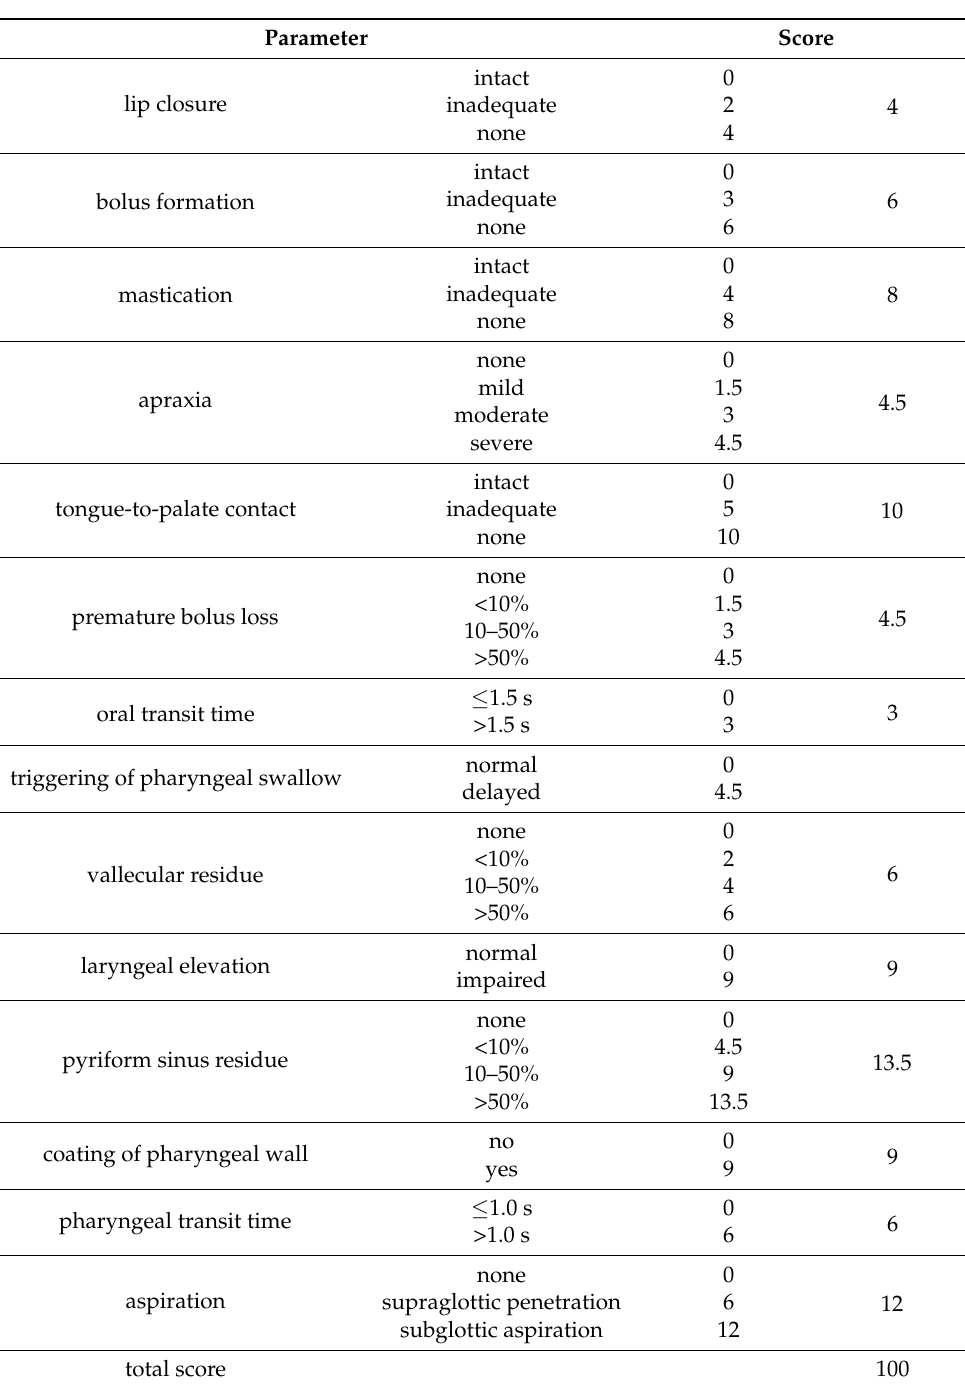
Table 1. Videofluoroscopic dysphagia scale